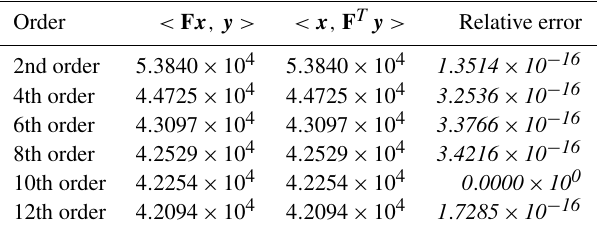
Table 2. Adjoint test for different discretization orders in 3-D, com- puted on a two-layer model in double precision. The highlighted values indicate the error in the values and indicate at which decimal the error